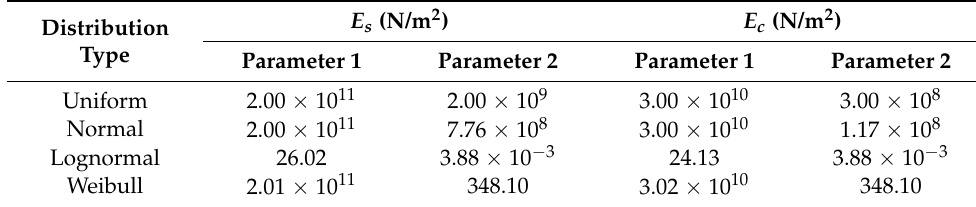
Table 5. Parameters under different distribution types.